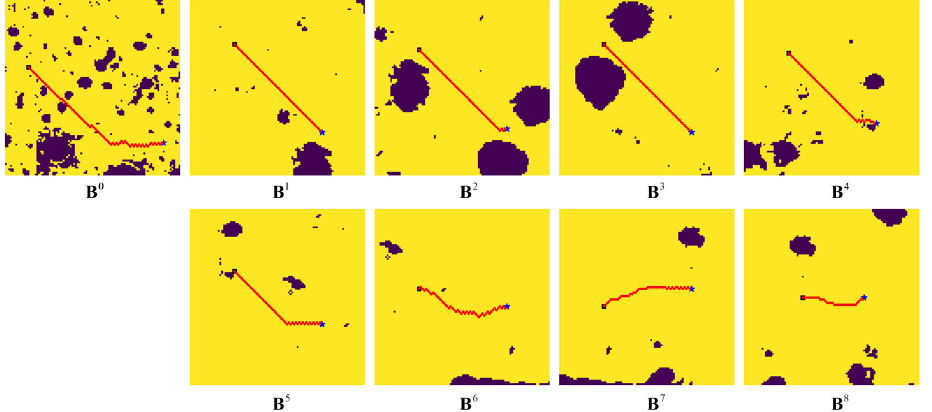
Figure 11. The planned paths by blocks for one of the planning tasks on Map 2.